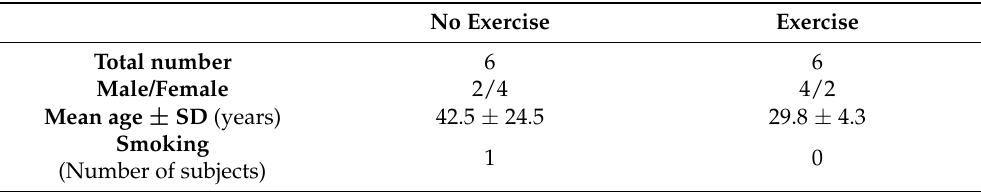
Table 1. Demographic data: “No exercise” group included individuals with less than 2 h per week of exercise and “exercise” group included individuals with more than 2 h per week of exercise. No Exercise Exercise Total number 6